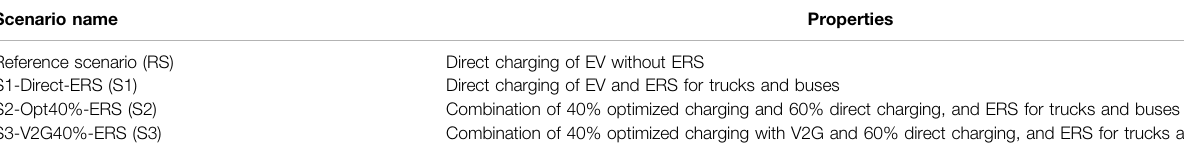
TABLE 2 | Descriptions of the scenarios for ELIN-EPOD and SCOPE.